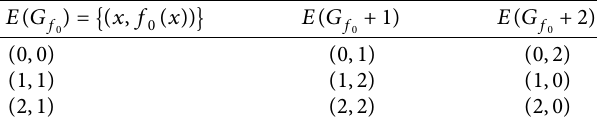
Table 3: Te graph G f 0 and it’s translates for Example 4.